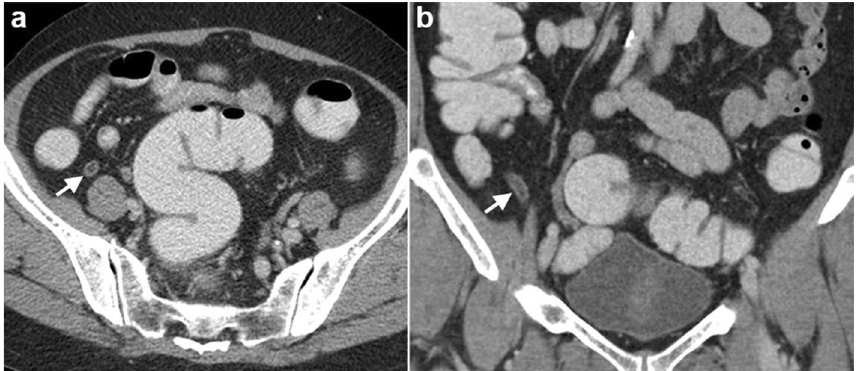
Figure 1. Acute appendicitis in a 65-year-old female with Alvarado score of 7. Cross-sectional ( a ) and coronal ( b ) computed tomography scan showing enlarged appendiceal diameter and wall thickening